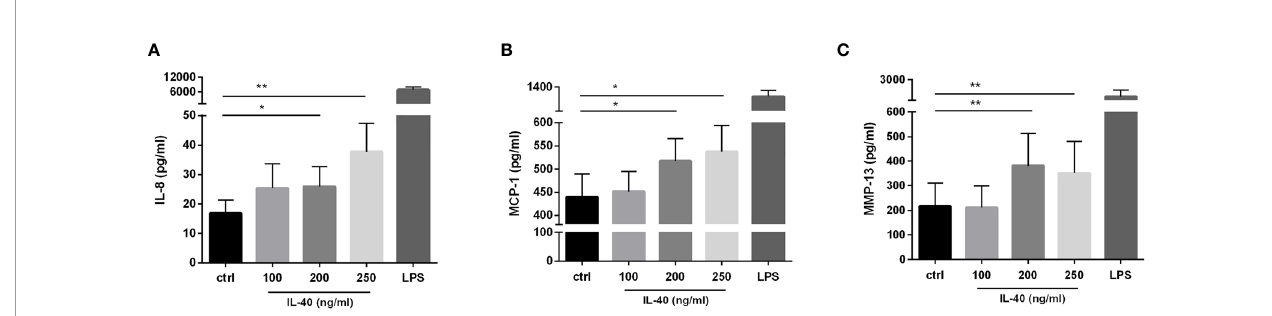
FIGURE 5 | IL-40 dose-dependently induced the secretion of pro-in fl ammatory cytokines/chemokines and MMP-13 in RA synovial fi broblasts (n=9). RA synovial fi broblasts signi fi cantly up-regulate the secretion of interleukin (IL)-8 (A) , monocyte chemoattractant protein (MCP)-1 (B) , and matrix-metalloproteinase (MMP)-13 (C) when treated by IL-40 at concentrations of 200-250 ng/ml. Fibroblasts were stimulated for 24h prior to protein analysis. Data are represented as mean ± SEM. *p < 0.05, **p < 0.01 compared to unstimulated fi broblasts